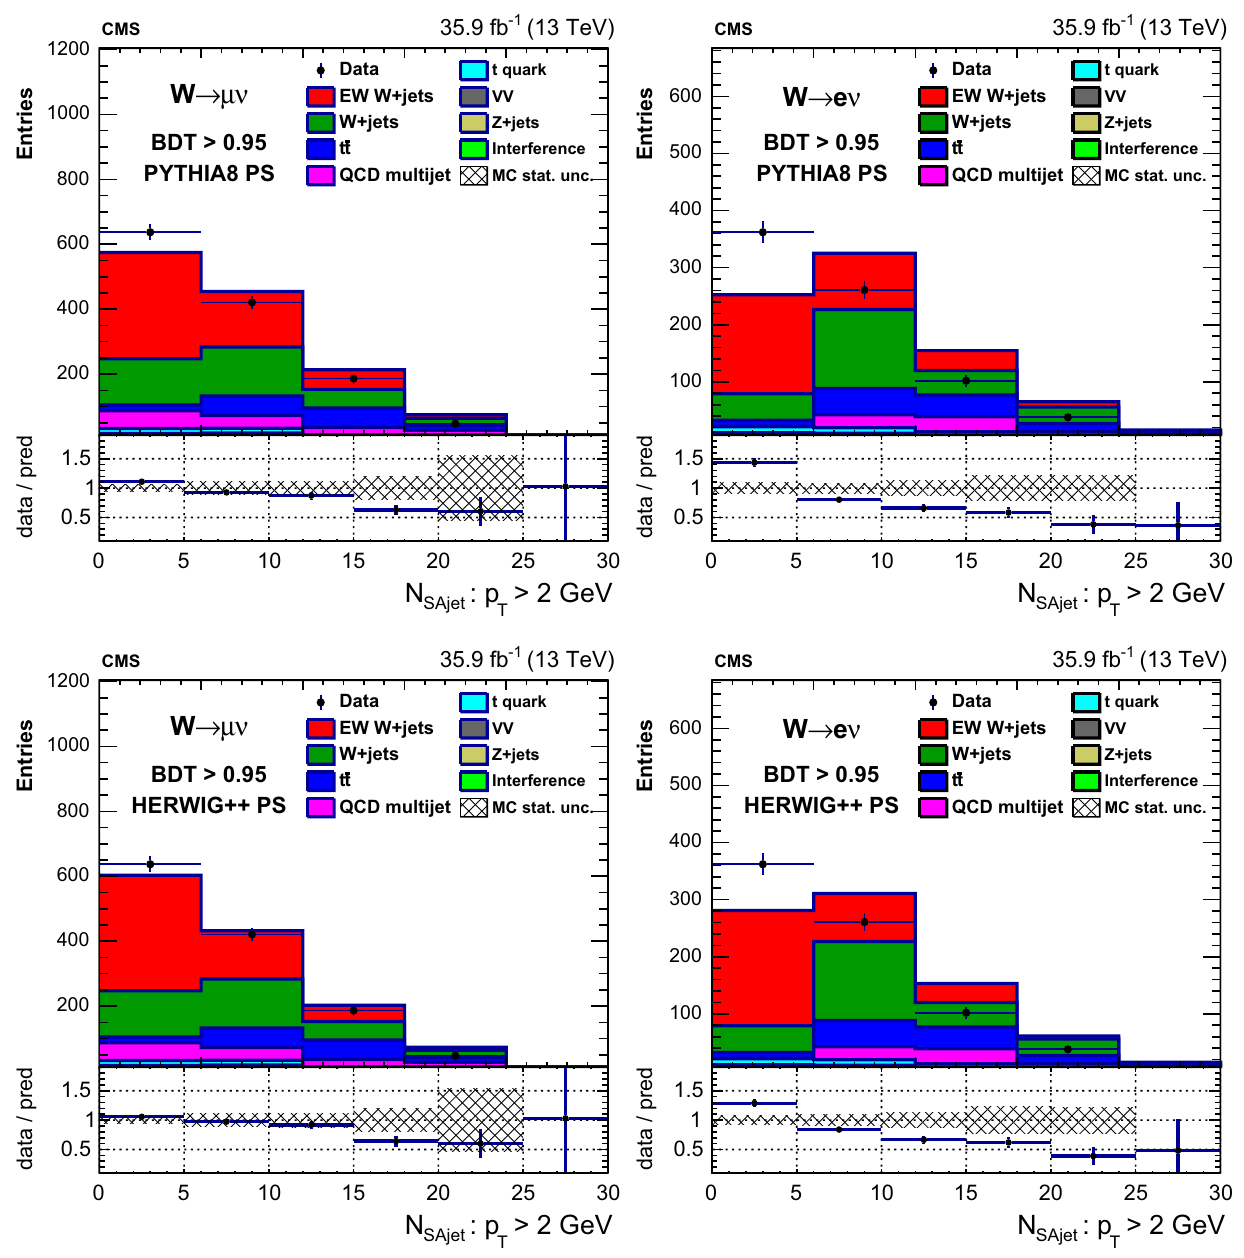
Fig. 22 Number of soft activity jets with p T > 2GeV in the rapidity gap for BDT > 0 . 95 in the muon (left) and electron (right) channels including signal with pythia parton showering (upper) and herwig++ parton showering